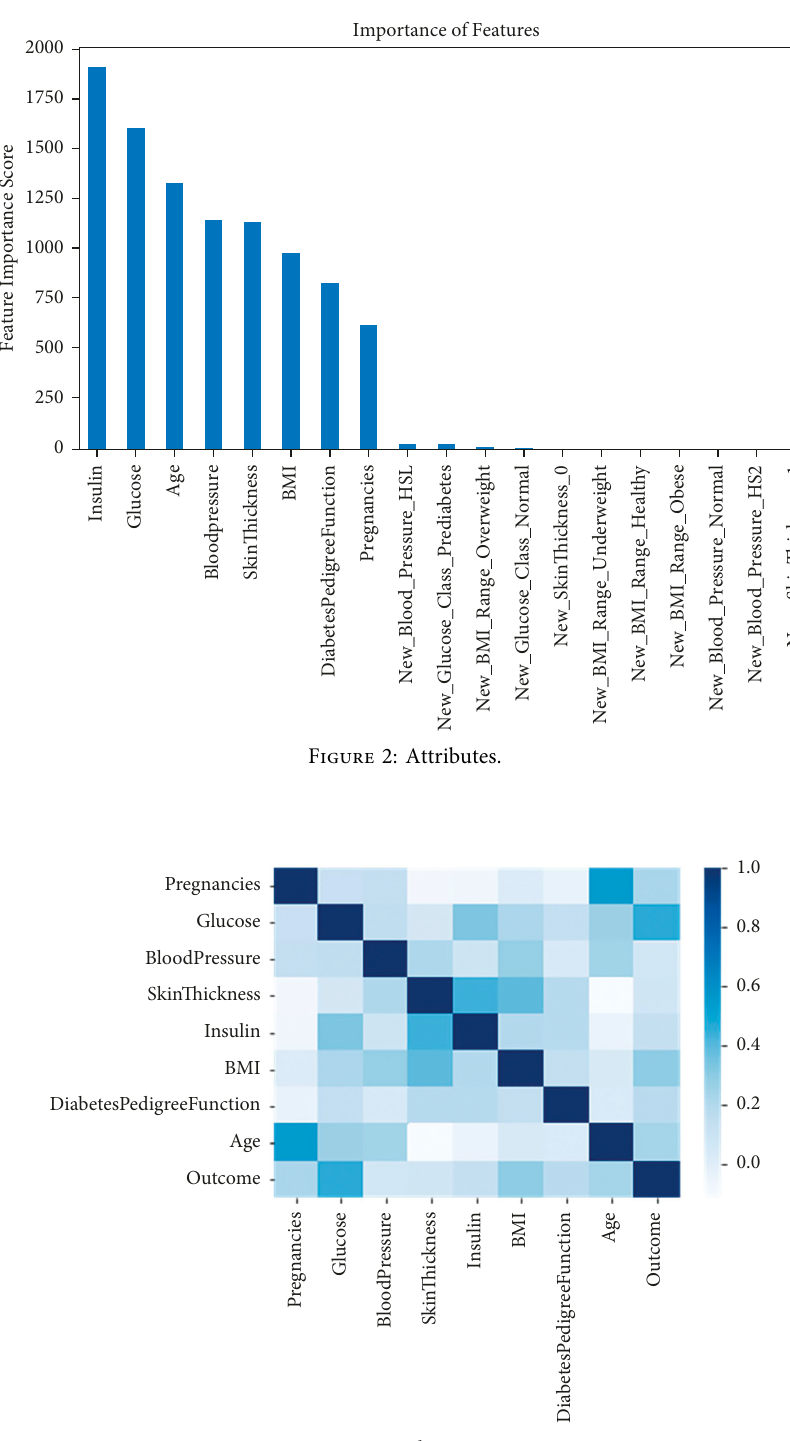
Figure 3: Correlation